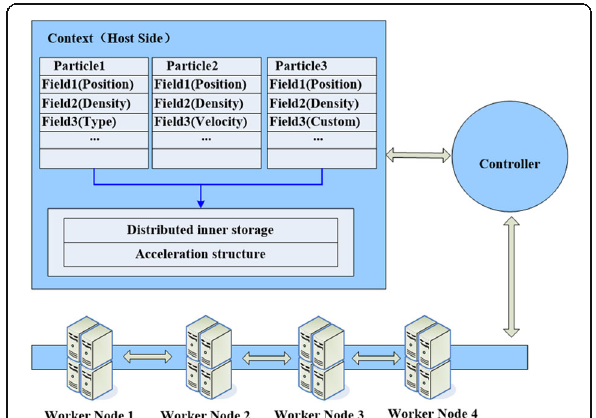
Fig. 6 The design of platform